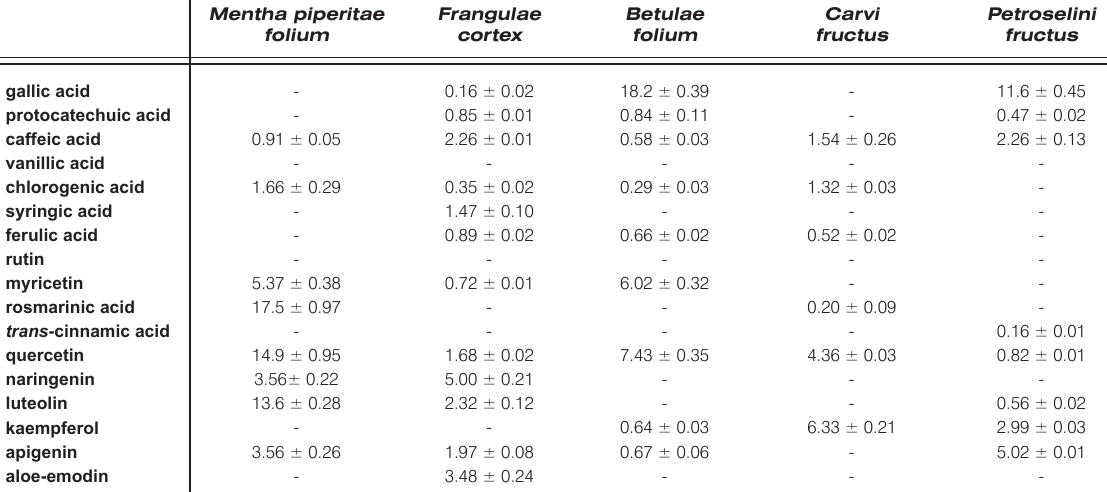
Table 3. Content of plant phenolics in crude extract after hydrolysis, expressed as mg g -1